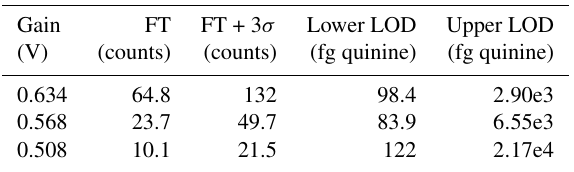
Table 3. Calibration responses and limits of detection for quinine for different gain voltage